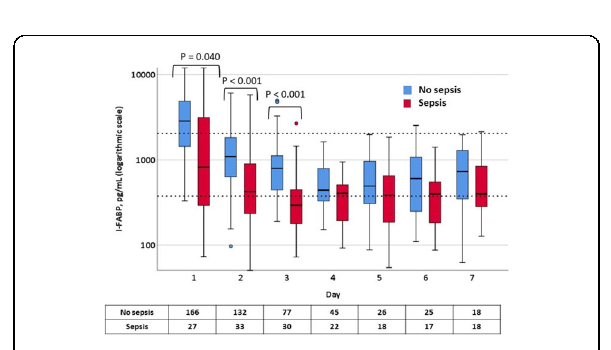
Fig. 3 (abstract 000698). Plasma I-FABP dynamics in sepsis vs no